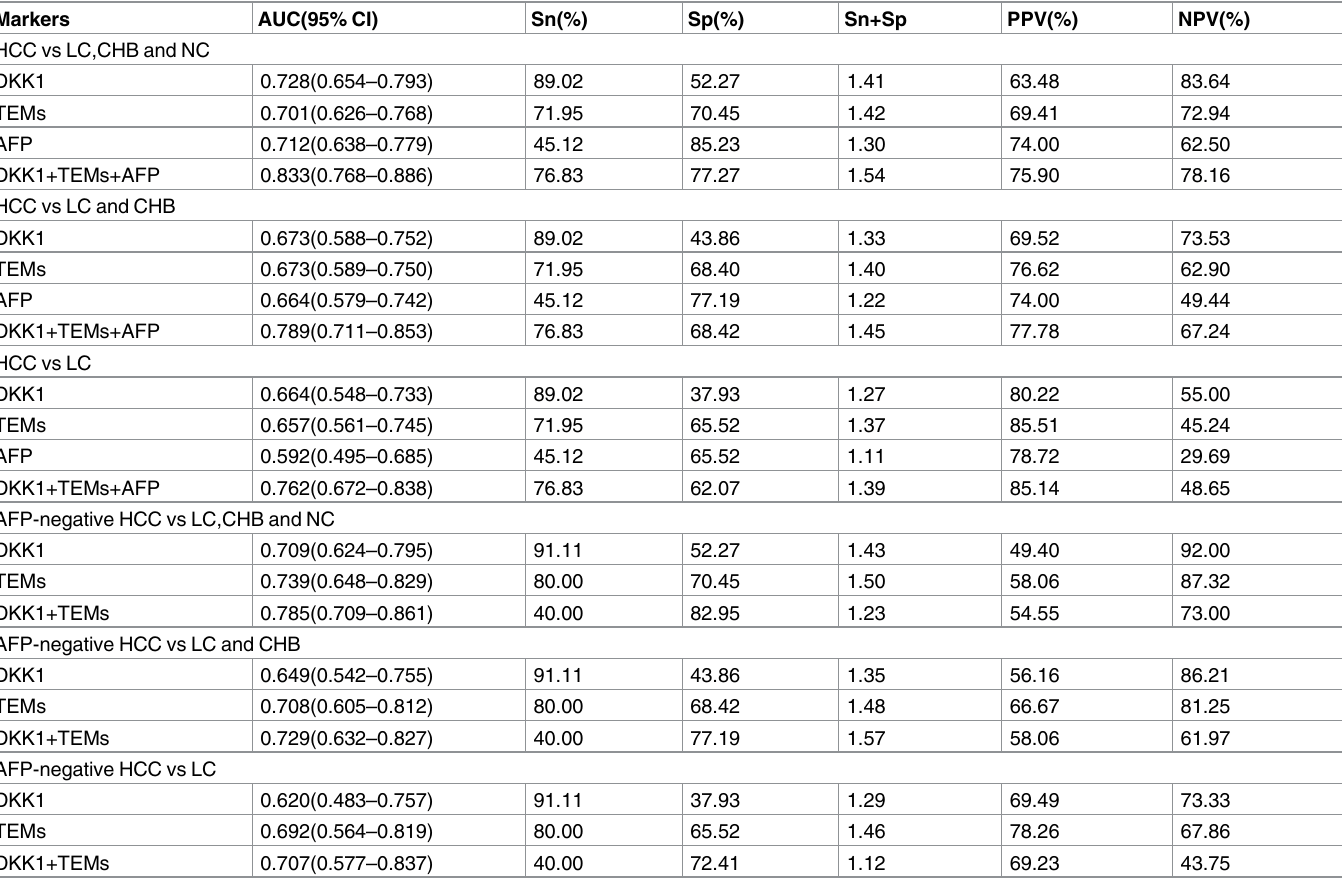
Table 3. Measurement results of DKK1, TEMs or AFP alone and their combinations for HCC diagnosis in different cohorts.